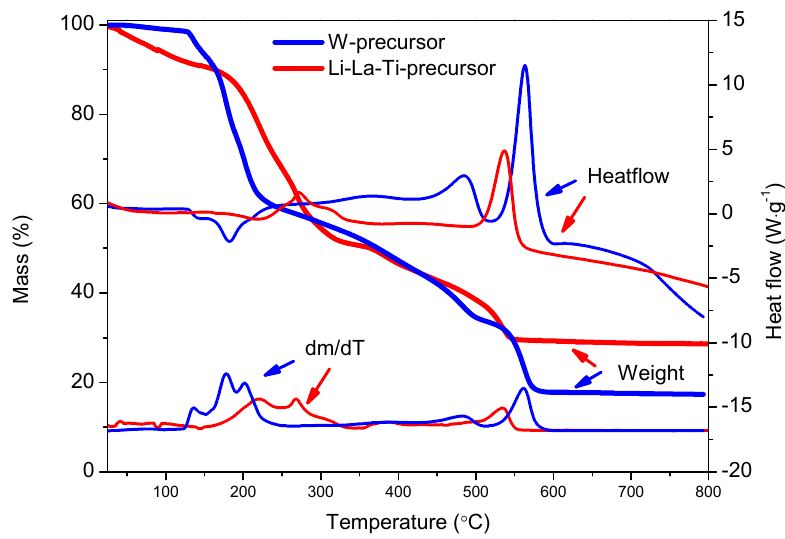
Figure 1. TGA-DSC analysis of the W- and Li-La-Ti-precursors dried at 60 °C, recorded at 10 °C·min − 1 in dry air.